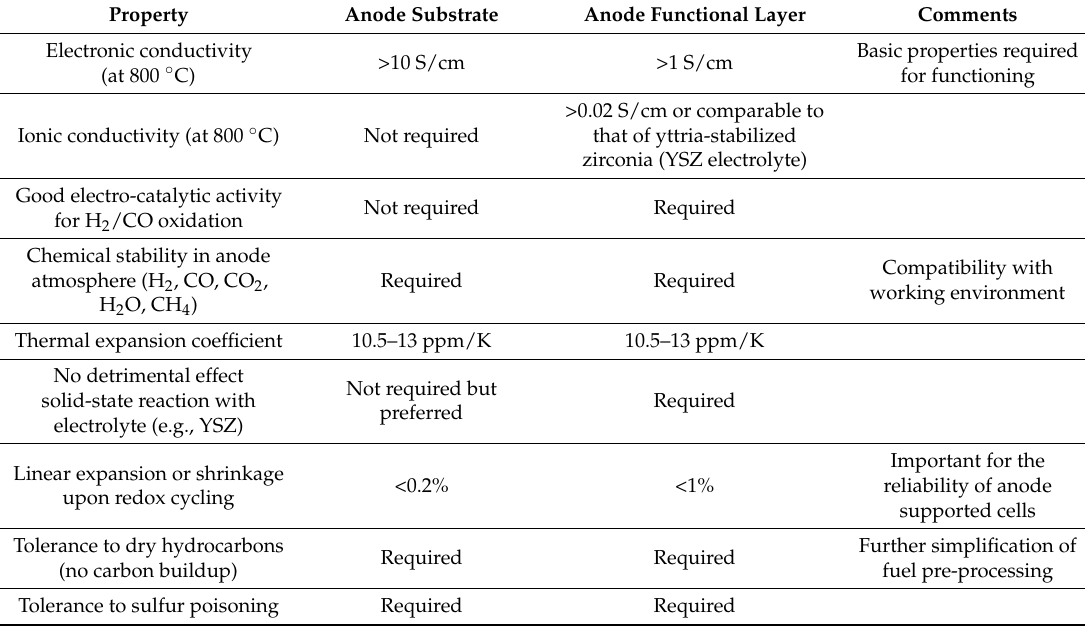
Table 1. Desirable properties of the anode substrate and functional layer materials